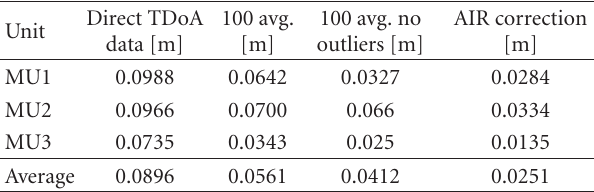
Table 5: Accuracy for no correction and AIR correction.